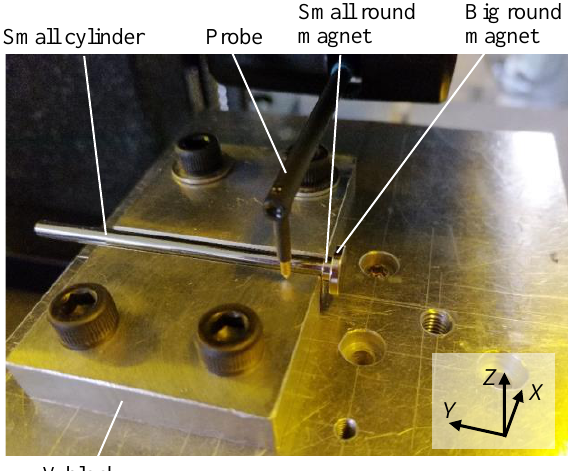
Figure 13. A schematic of the workpiece-holding mechanism: ( a ) Before modification; ( b ) After modification.